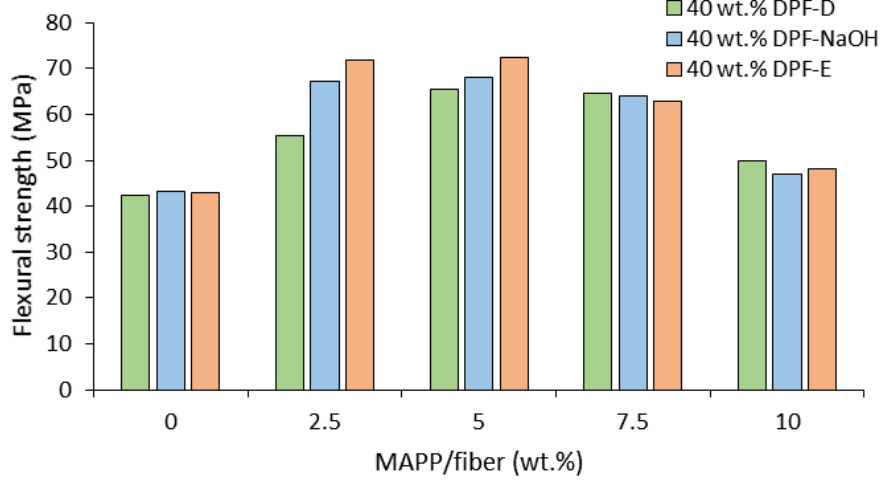
Figure 5. Effect of coupling agent concentration on composites loaded with a 40 wt.% of date palm fibers.